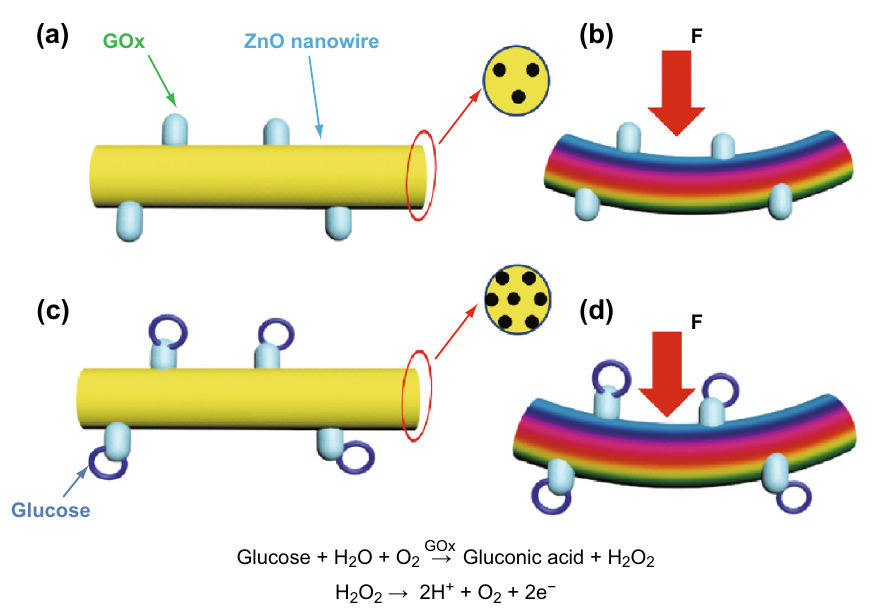
Fig. 5 Working mechanism of self-powered implantable skin-like glucometer. a GOx/ZnO nanowires in pure water without applied deformation. b The piezoelectric output of GOx/ZnO nanowires in pure water under applied deformation. c GOx/ZnO nanowires in glucose aqueous solution without applied deformation. d The piezoelectric output of GOx/ZnO nanowires in glucose aqueous solution under applied